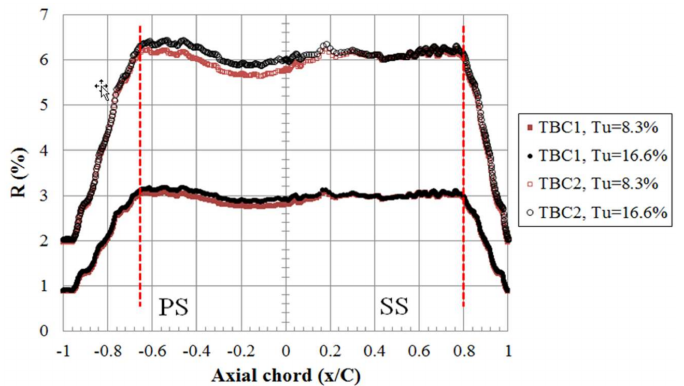
Figure 14. Percentage of metal temperature reduction ( R ) of two TBCs at midspan and Tu = 8.3% and 16.6%.